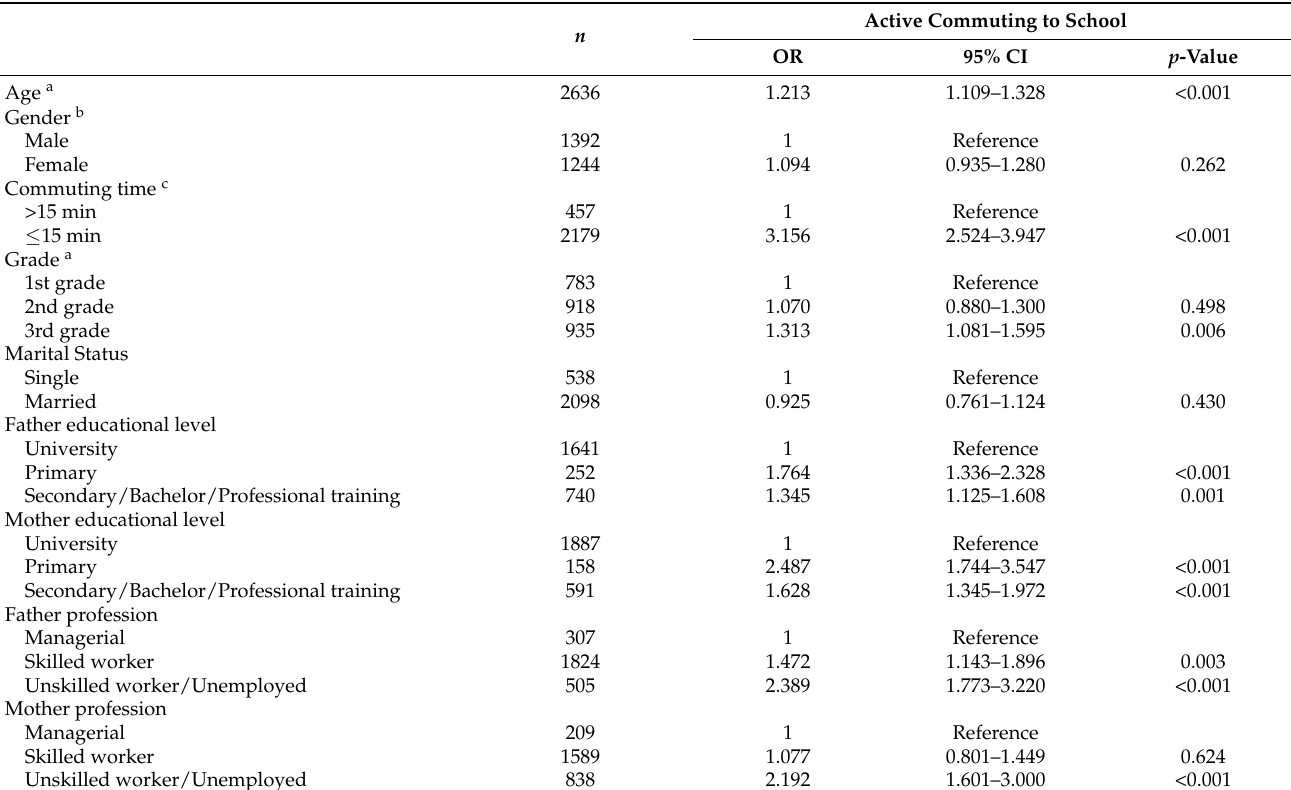
Table 2. Associations between active commuting to school and socio-economic factors.